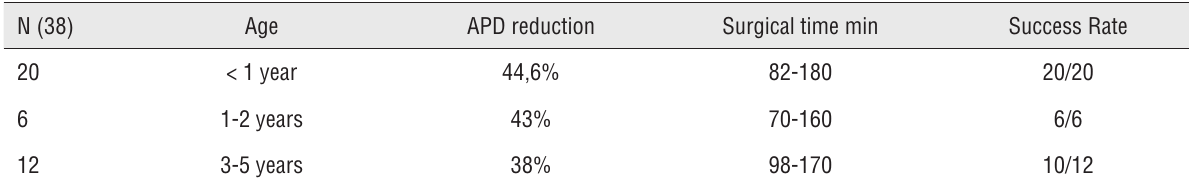
Table 2 - Laparoscopic Pyeloplasty - results by